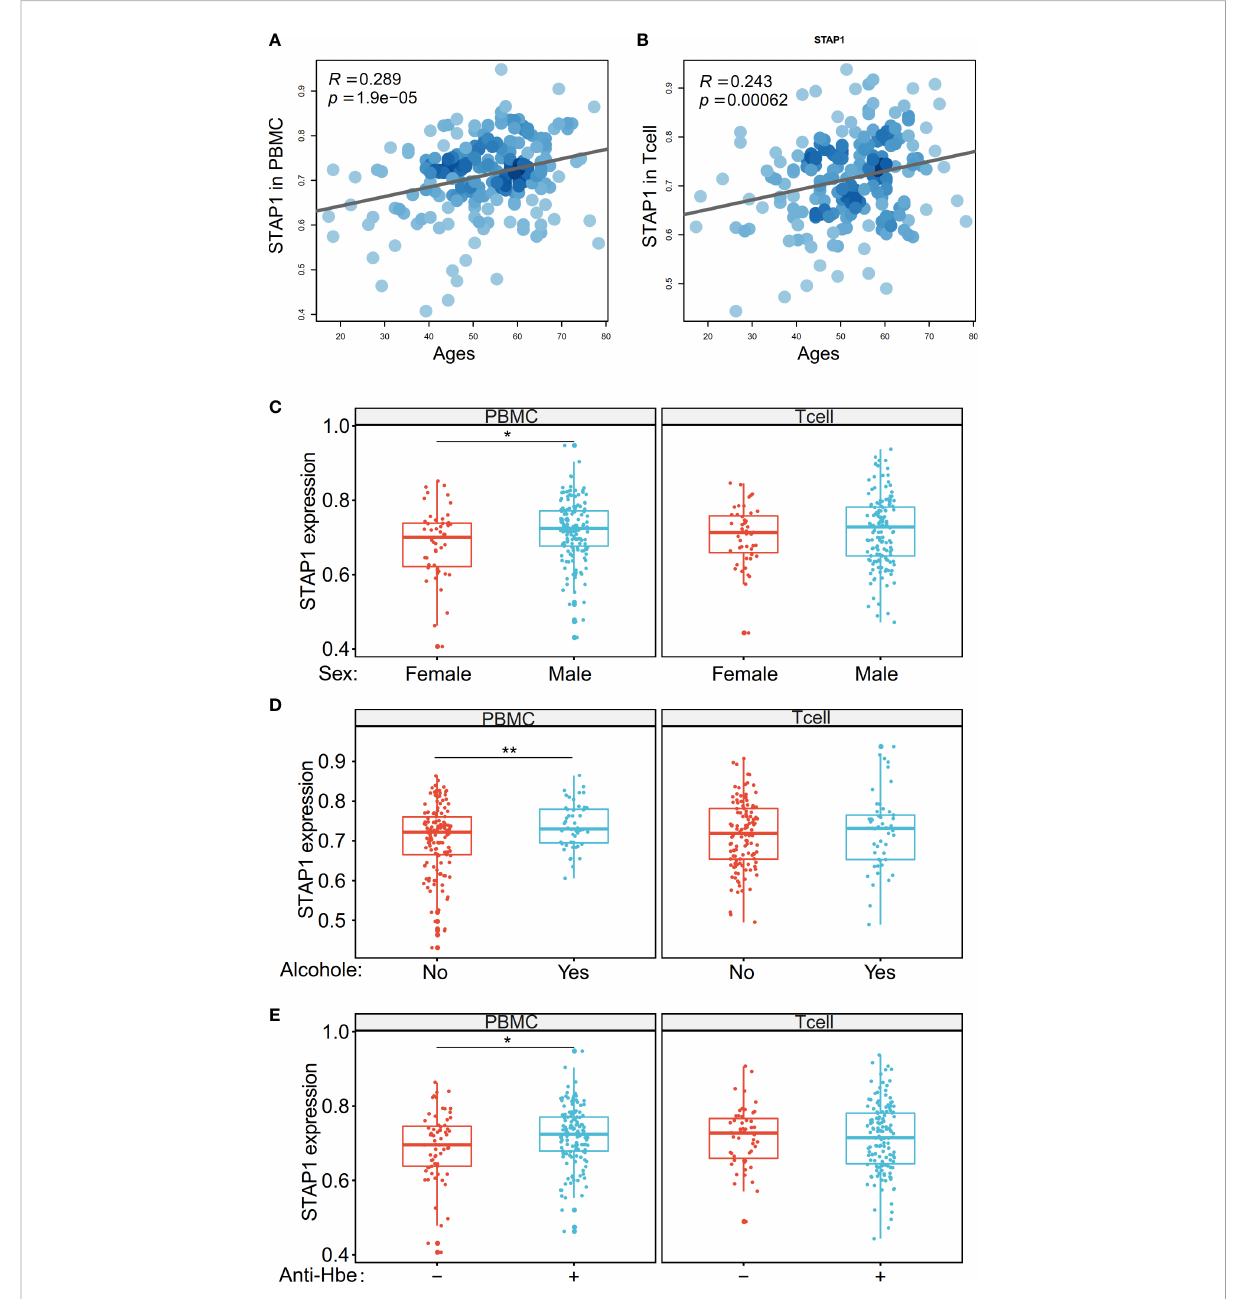
FIGURE 5 The methylation level of STAP1 was correlated with age, sex, alcohol drinking, and anti-HBe in peripheral blood mononuclear cells (PBMC) and T cells. (A, B) Correlation of STAP1 methylation level with ages in PBMC and T cells. (C) Difference of STAP1 methylation in different genders in PBMC and T cells. (D) Difference of STAP1 methylation between PBMC and T cells relative to alcohol abuse. (E) Difference of STAP1 methylation between anti-HBe+ and anti-HBe- patients in PBMC and T cells. *P < 0.05, **P <